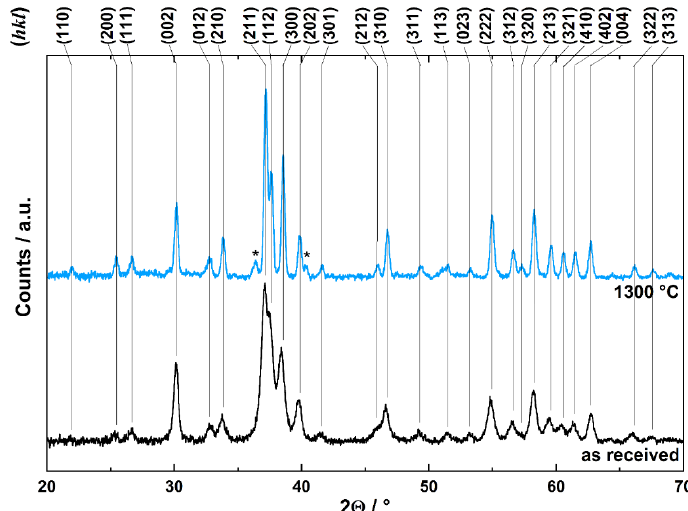
Figure 5. X-ray diffraction patterns of as received CDHA ( bottom ) and after the material sintering at 1300 °C ( top ) with respective (hkl) indexes. Asterisks describe two diffractions of lesser intensity observed at 36.4 and 40.3 ° 2Θ.